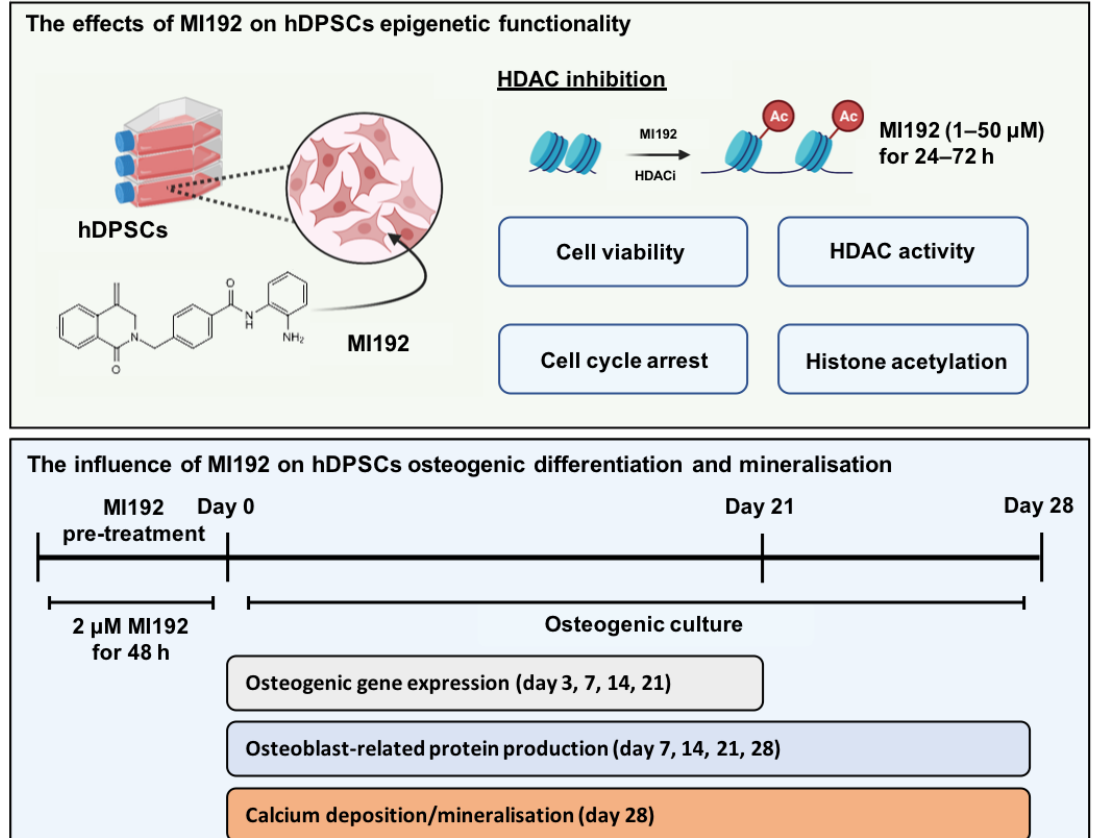
Figure 1. Experimental outline investigating the effects of altering hDPSCs epigenetic functionality with MI192 on their osteogenic capacity.